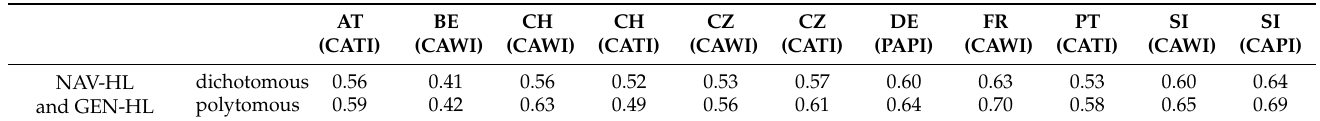
Table 8. Pearson correlation between the HLS 19 -NAV scores and the HLS 19 -Q12 scores based